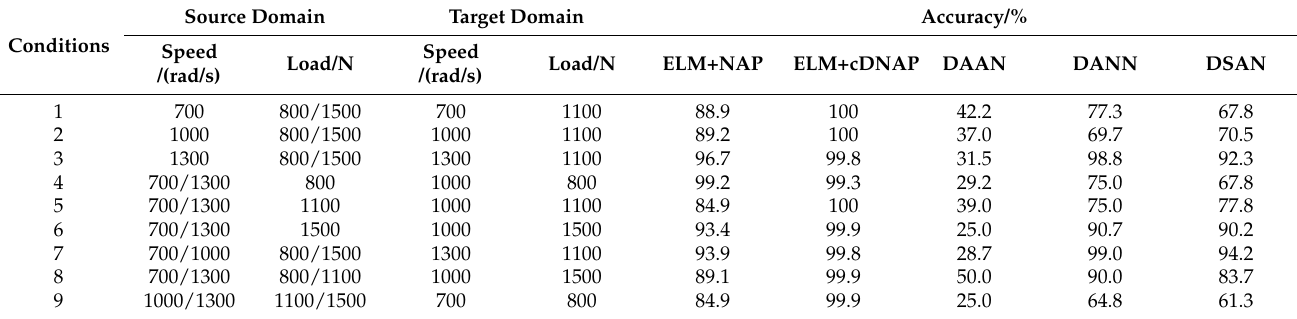
Table 4. Diagnostic results of comparison tests.